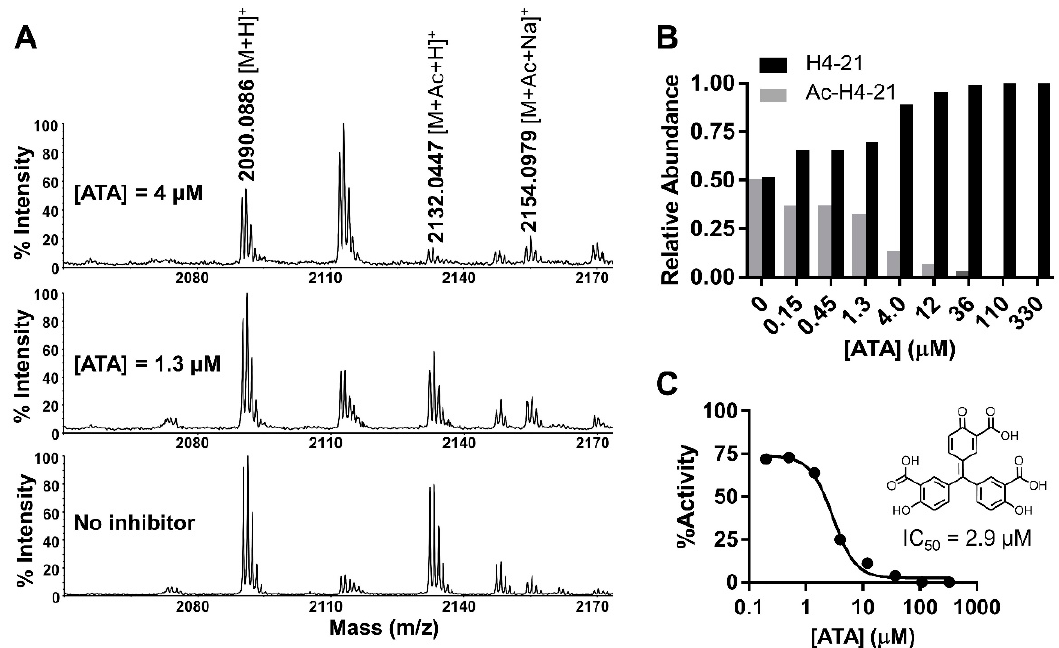
Figure 7. MALDI-MS acetylation inhibition assay for aurintricarboxylic acid (ATA) ( n = 1). ( A ) Representative MS at 0, 1.3, and 4 μ M of ATA. ( B ) Quantification of ATA inhibition. ( C ) IC 50 of ATA.